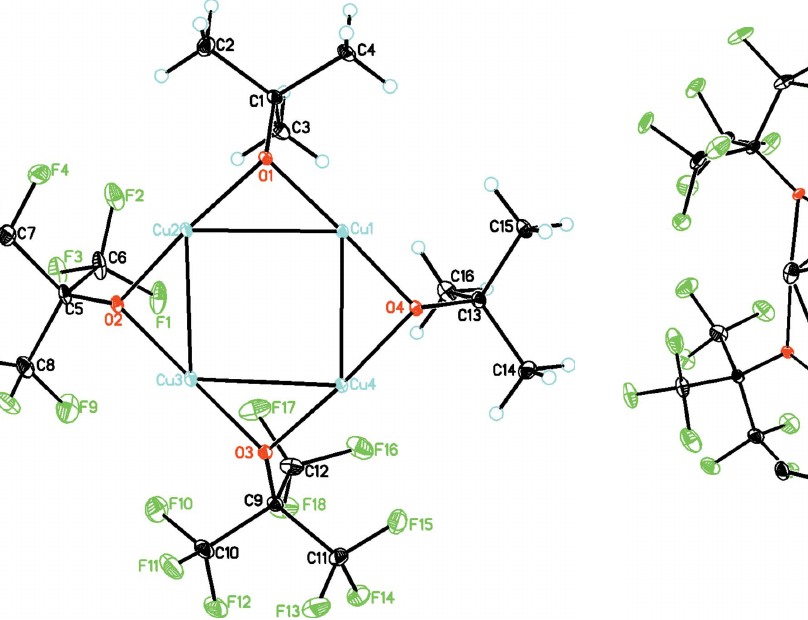
Figure 1 Molecular diagram for the major component of 1 showing the atom labeling. Atomic displacement parameters are at the 30%